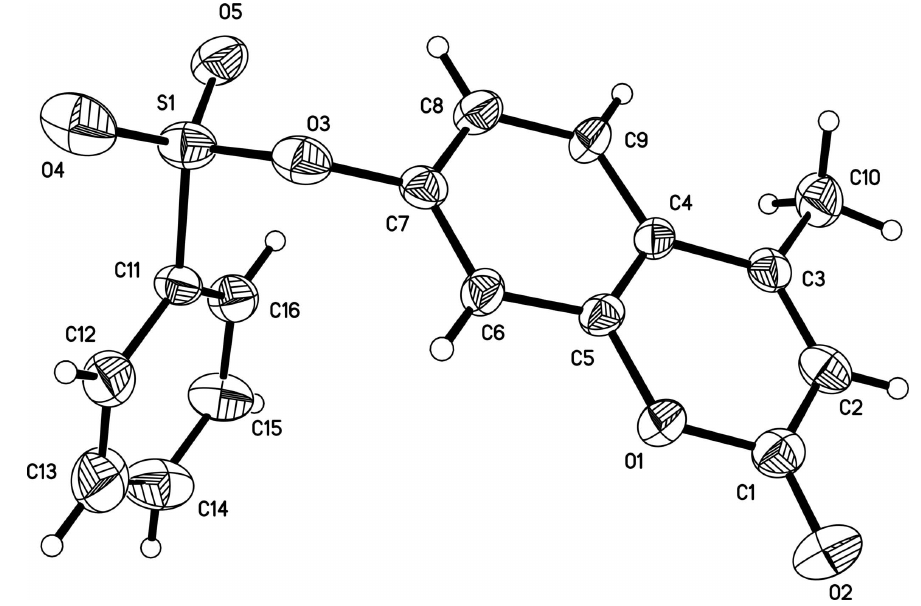
Figure 1 The molecular structure of the title compound. Displacement ellipsoids are drawn at the 30% probability